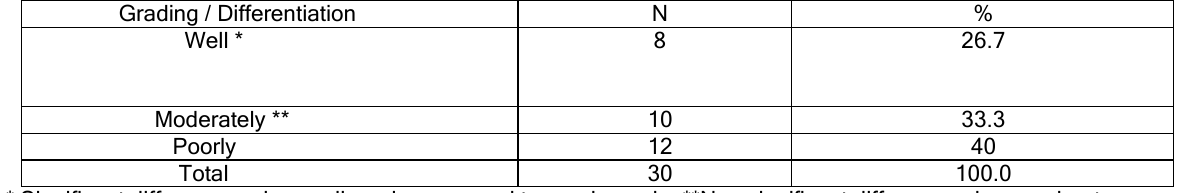
grade compared to poorly grade.